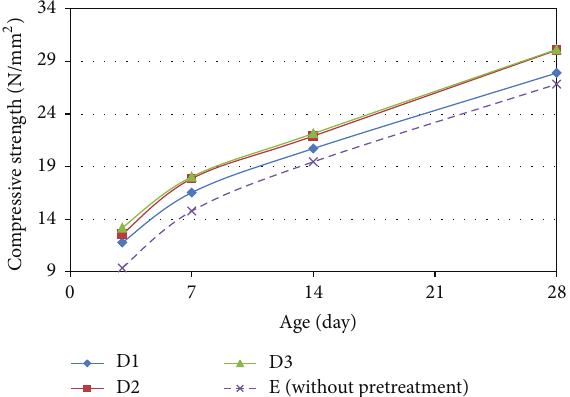
Figure 13: Influence of different concentrations of NaOH on the compressive strength of